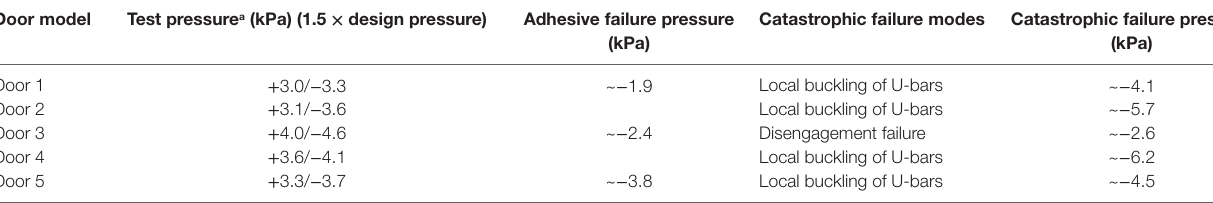
TaBle 3 | summary of the pressure at failure of test specimens. Door model